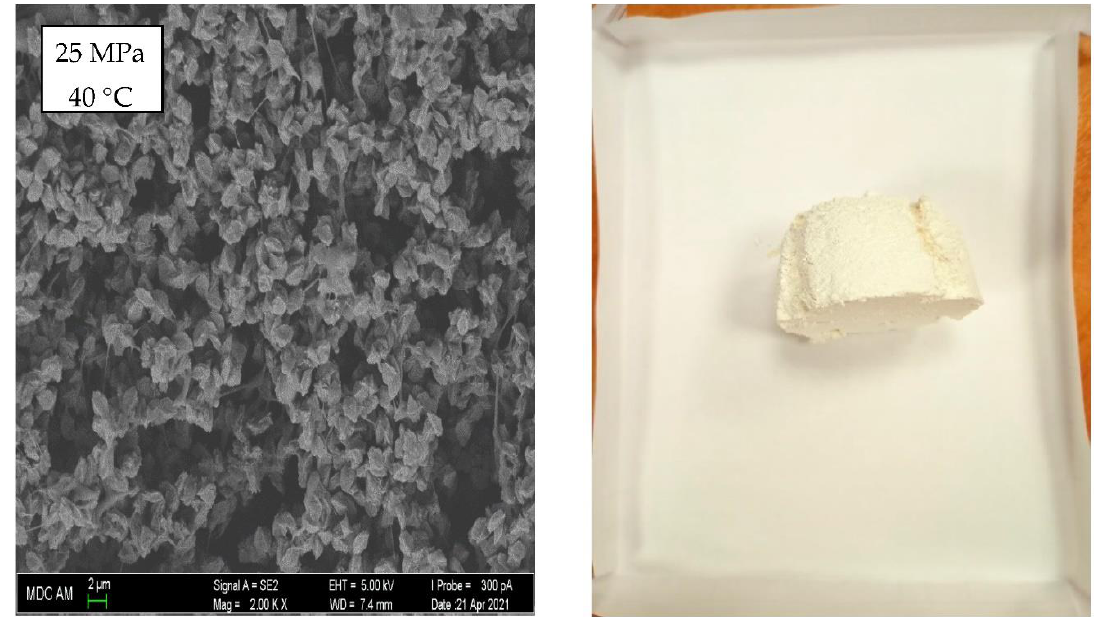
Figure 4. SEM image (phase morphology, left ) of the polymer blend microparticles with a composition of PP-01030 (75%)/EPTSR-50 (25%) and photo ( right ) produced by SEDS at a temperature of t = 40 °C and pressure Р = 25 MPa (see Table 3, operating condition No. 5).